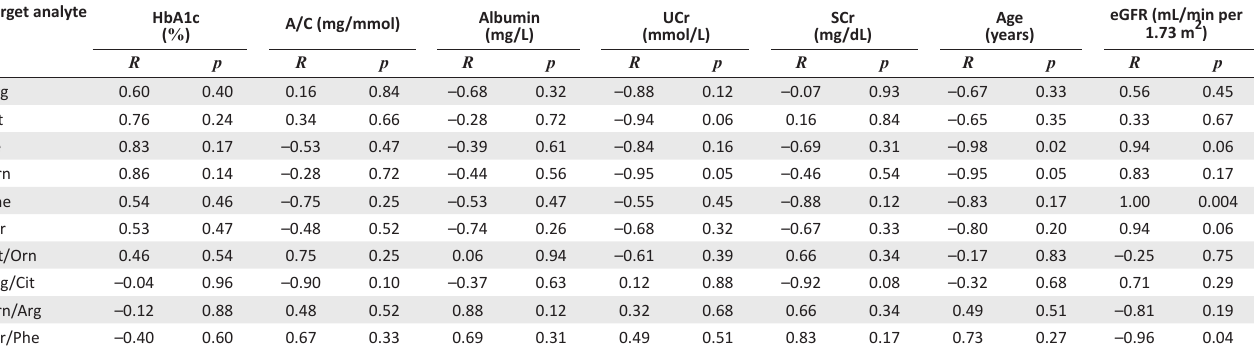
TABLE 2: Correlation between the amino acid concentrations and ratios and clinical data of patients with diabetes, Johannesburg, South Africa, November 2019 to January 2021. Target analyte